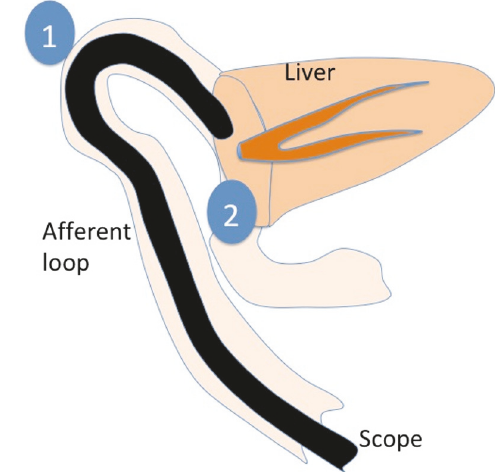
Figure 2: Because the afferent loop invaginates into the space after right lobectomy, the scope is difficult to move on ( A ) and bile juice is easy to stagnate ( B